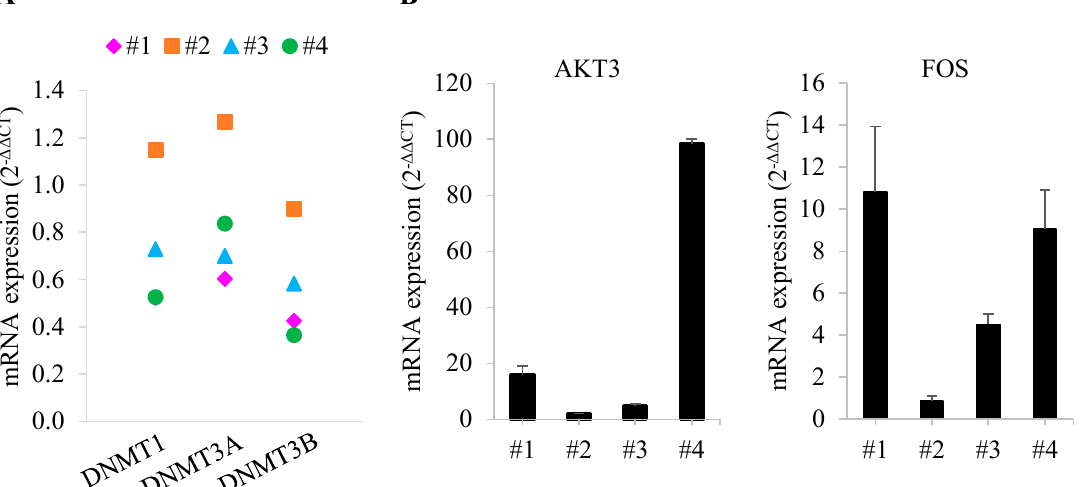
Figure 6. Comparison of gene expression in MDS patients with and without DEC treatment. ( A ) Comparison of DNMT1, DNMT3A, and DNMT3B mRNA expression levels by patient. ( B ) Confirmation of differences in mRNA expression of AKT3 and FOS for each patient. All differences in expression are significant at the p < 0.05 level. Error bars indicate SD ( n = 3).